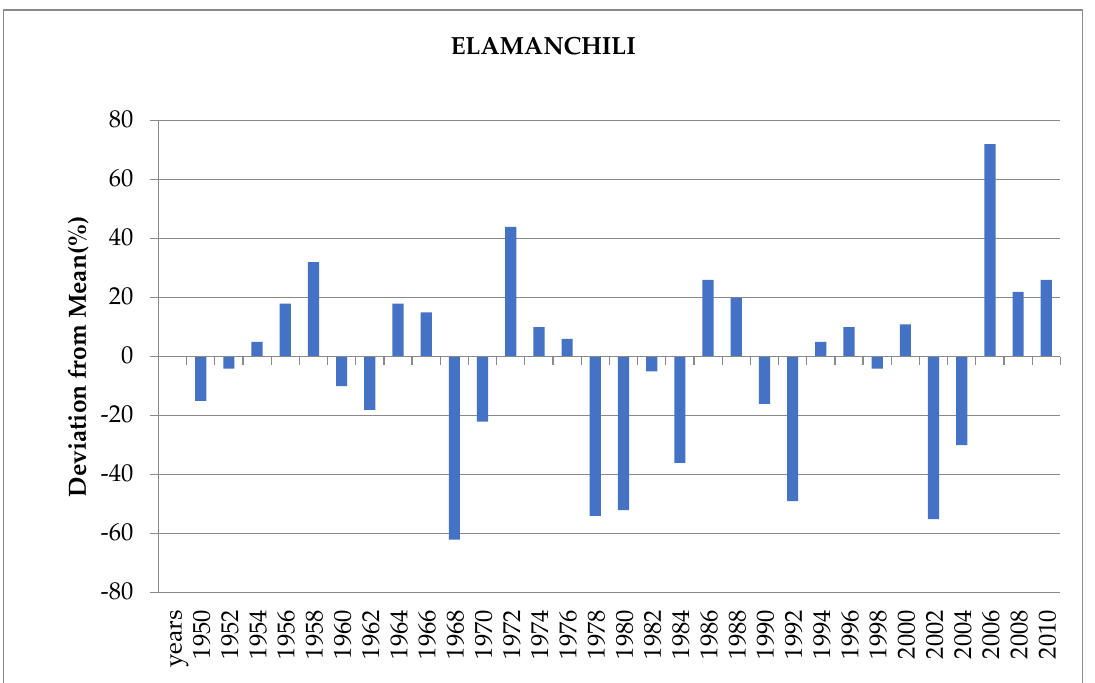
Figure 11. Elamanchili. Figure 11.